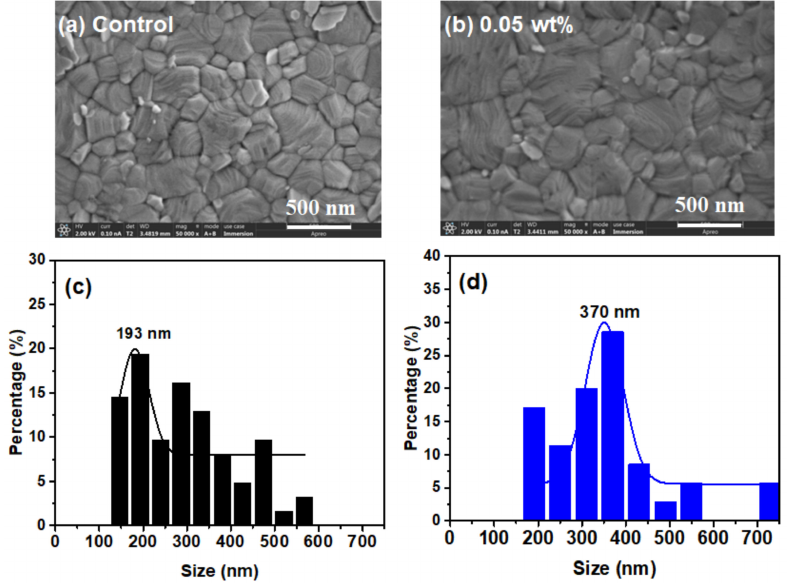
Figure 5. Surface topographic SEM and histograms of grain size distributions of the MAPbI 3 perovskite film with and without additive 2 : ( a , c ) pristine films and ( b , d ) perovskite films with 0.05 wt% 2